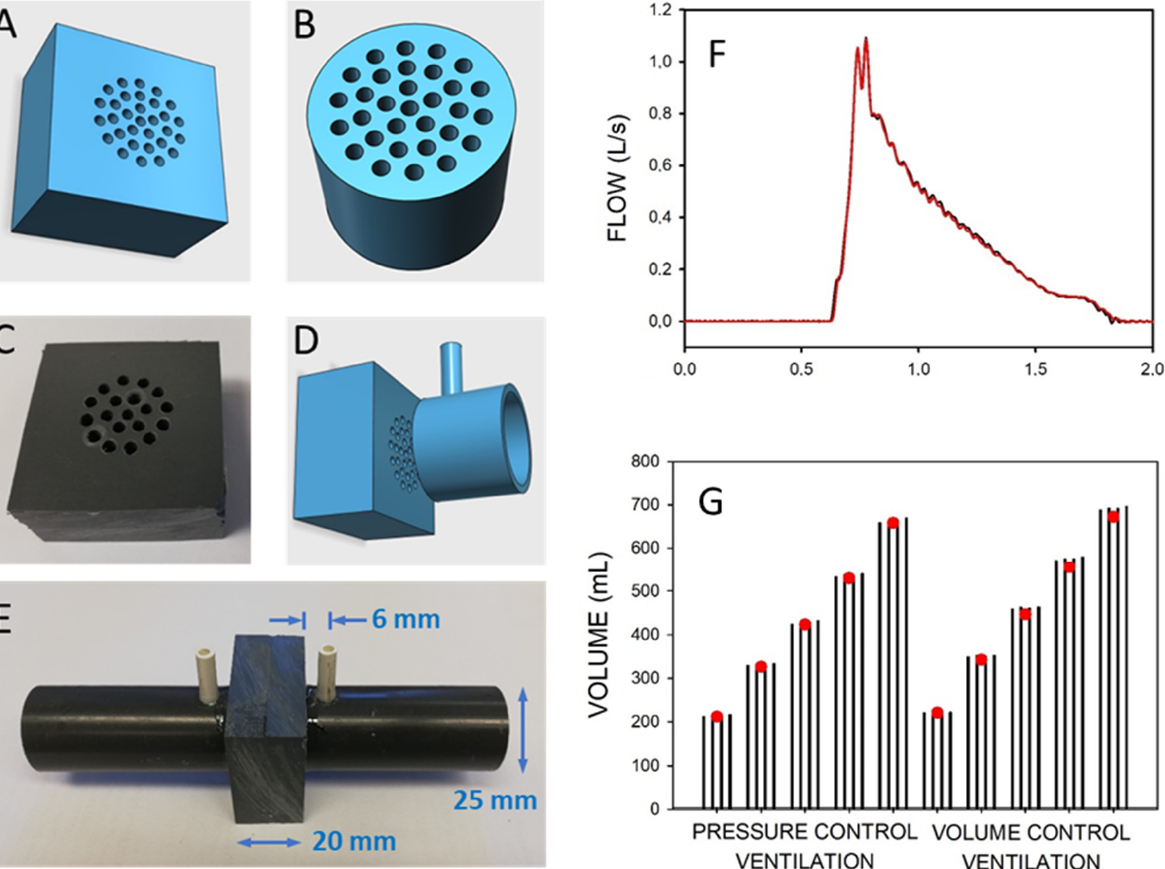
Figure 3. Low-cost pneumotachograph. ( A , B ) Diagrams of resistors for the pneumotachographs. ( B , C ) Photograph of the manually drilled resistor. ( C , D ) Diagram of resistor and (one side) standard PVC tube piece to assemble the pneumotach. ( E ) Photograph of the assembled pneumotachograph. ( F ) Example of the flow signals during pressure-controlled mechanical ventilation simultaneously calibrated by the low-cost procedures (black). ( G ) Volume measured during different magnitudes